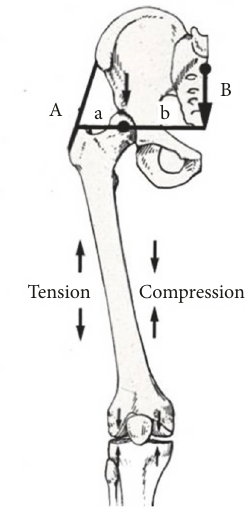
Figure 1: The Koch model of hip biomechanics(1) is static cadaveric model, (2) demonstrates his hypothesis of hip loading, and (3) requires the gluteus medius to exert a force twice that of the body’s weight in order to maintain equilibrium during single stance.